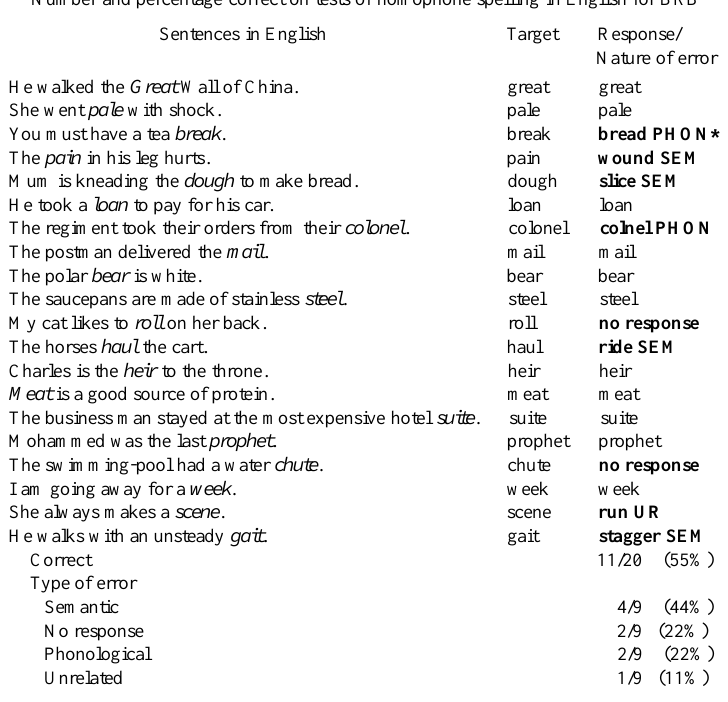
Table 2 Number and percentage correct on tests of homophone spelling in English for BRB Sentences in English Target Response/ Nature of error He walked the Great Wall of China. great great She went pale with shock. pale